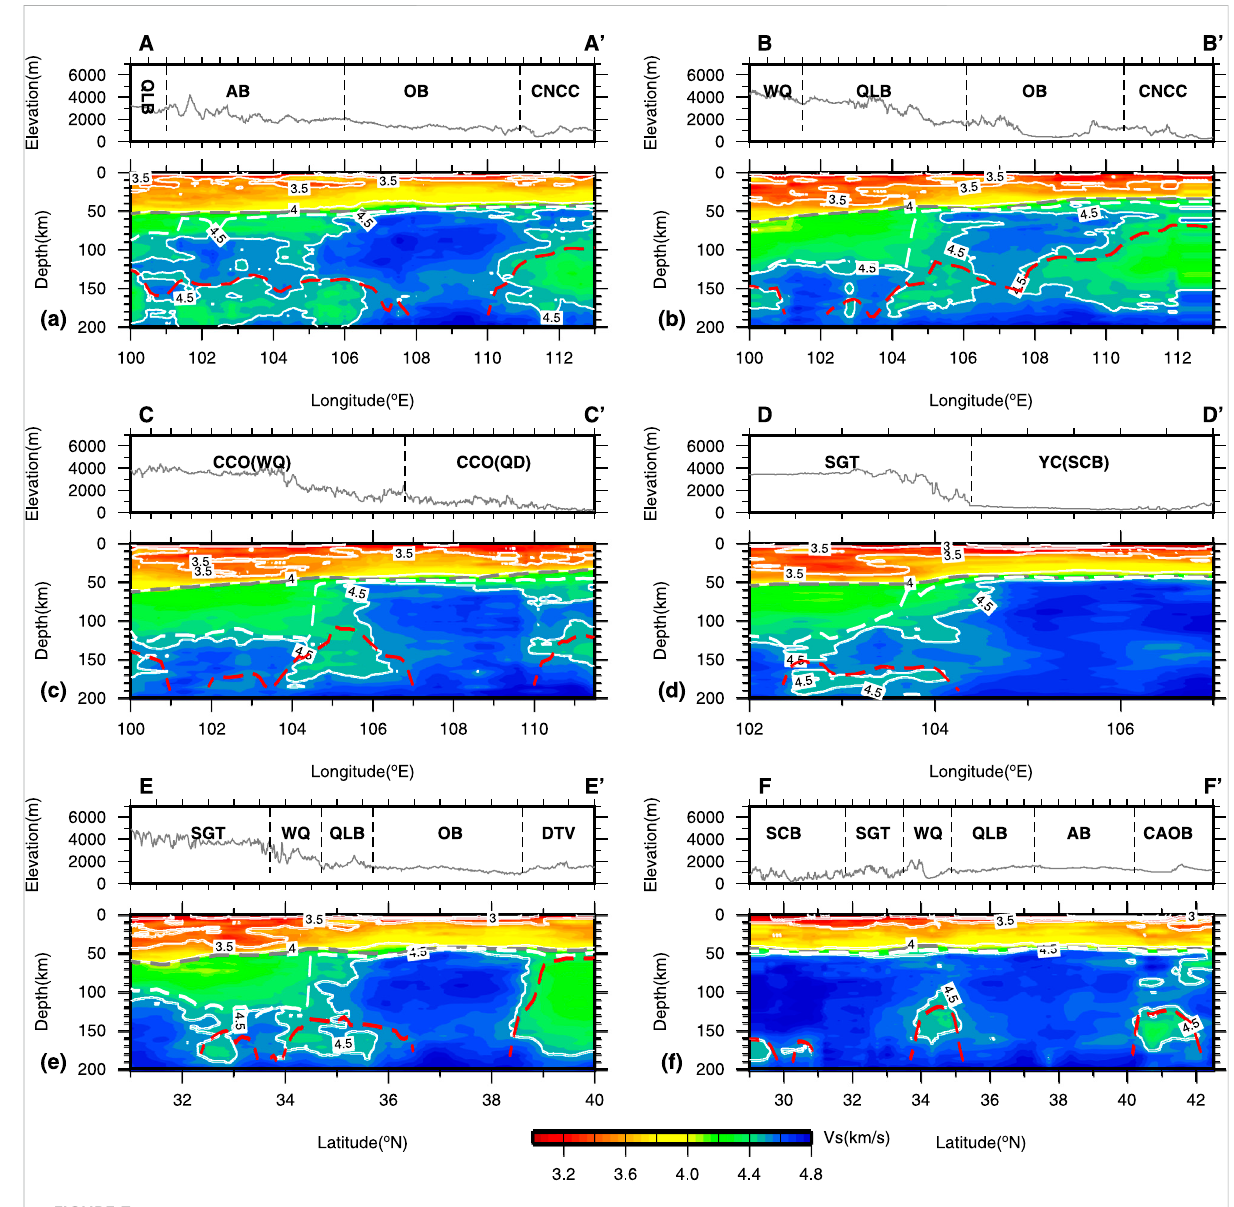
FIGURE 7 S-wavevelocitystructurebeneath6sectionsinthestudyregion. (A) AA ’ section; (B) BB ’ section; (C) CC ’ section; (D) DD ’ section; (E) EE ’ section; (F) FF ’ section. Thelocations ofthesixsectionsare shown inFigure 1. Thegray, redand white dashedlinesrepresent thedepth ofMoho,LAB andthe lower boundary of